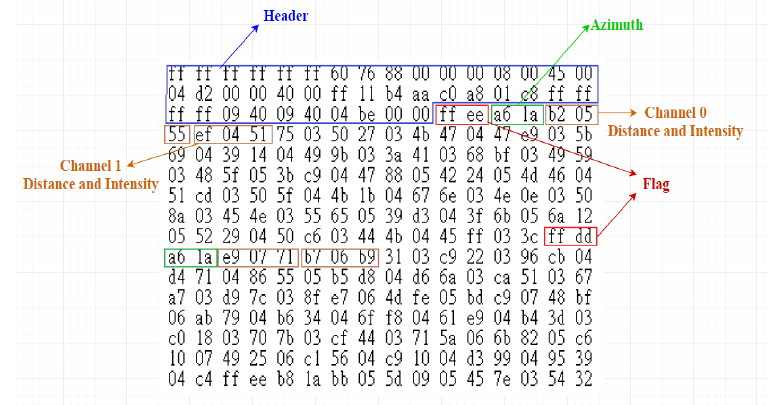
Figure 3. The actual packet diagram.